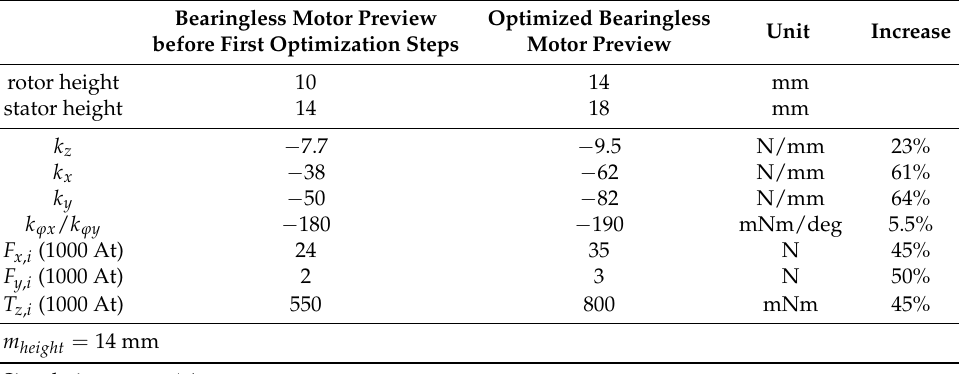
Table 13. Final results and comparison of the unoptimized and optimized FSPM